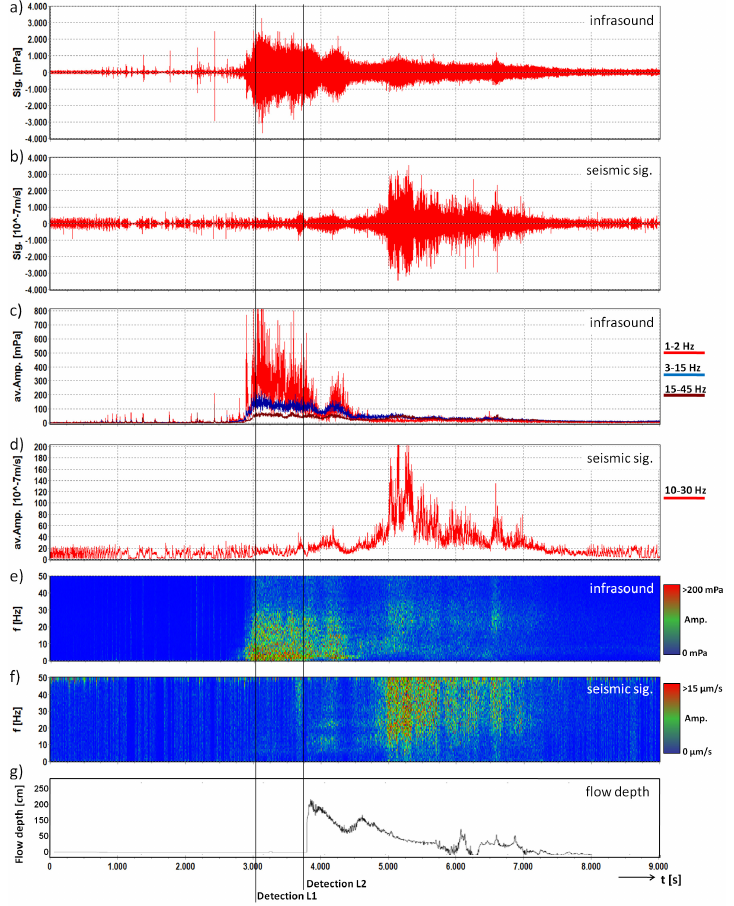
Figure 5. Infrasound and seismic data of the mudflow monitored at the Marderello test site on 9 August 2015. Signals are represented with a common base of time. ( a ) infrasound time series; ( b ) seismogram; ( c ) average amplitude of the three frequency bands of the infrasound signal; ( d ) average amplitude of the frequency band of the seismic signal; ( e ) running spectrum of the infrasound signal; ( f ) running spectrum of the seismic signal; ( g ) flow depth ( ∼ 70m downstream); lines: time of first detection for Levels 1 and 2. The largest amplitudes of the infrasound signal occur at 3 Hz with 749 mPa and the maximum amplitude of the seismic signals was recorded at 23 Hz with 76 µ m/s. The detection algorithm